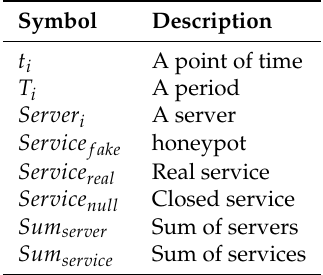
Table 1. Notations used in system